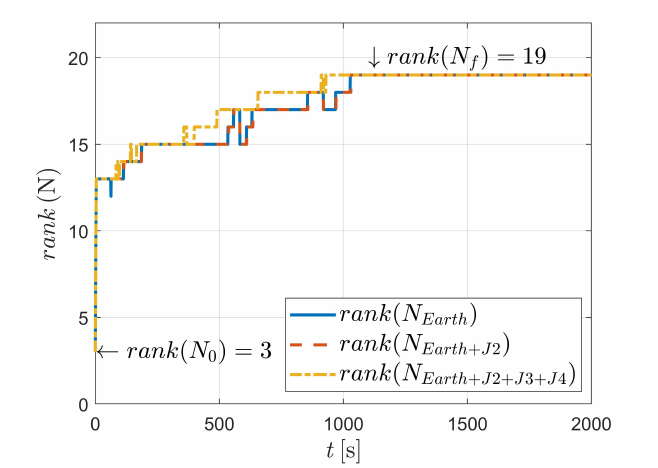
Figure 18. Observability comparisons of case